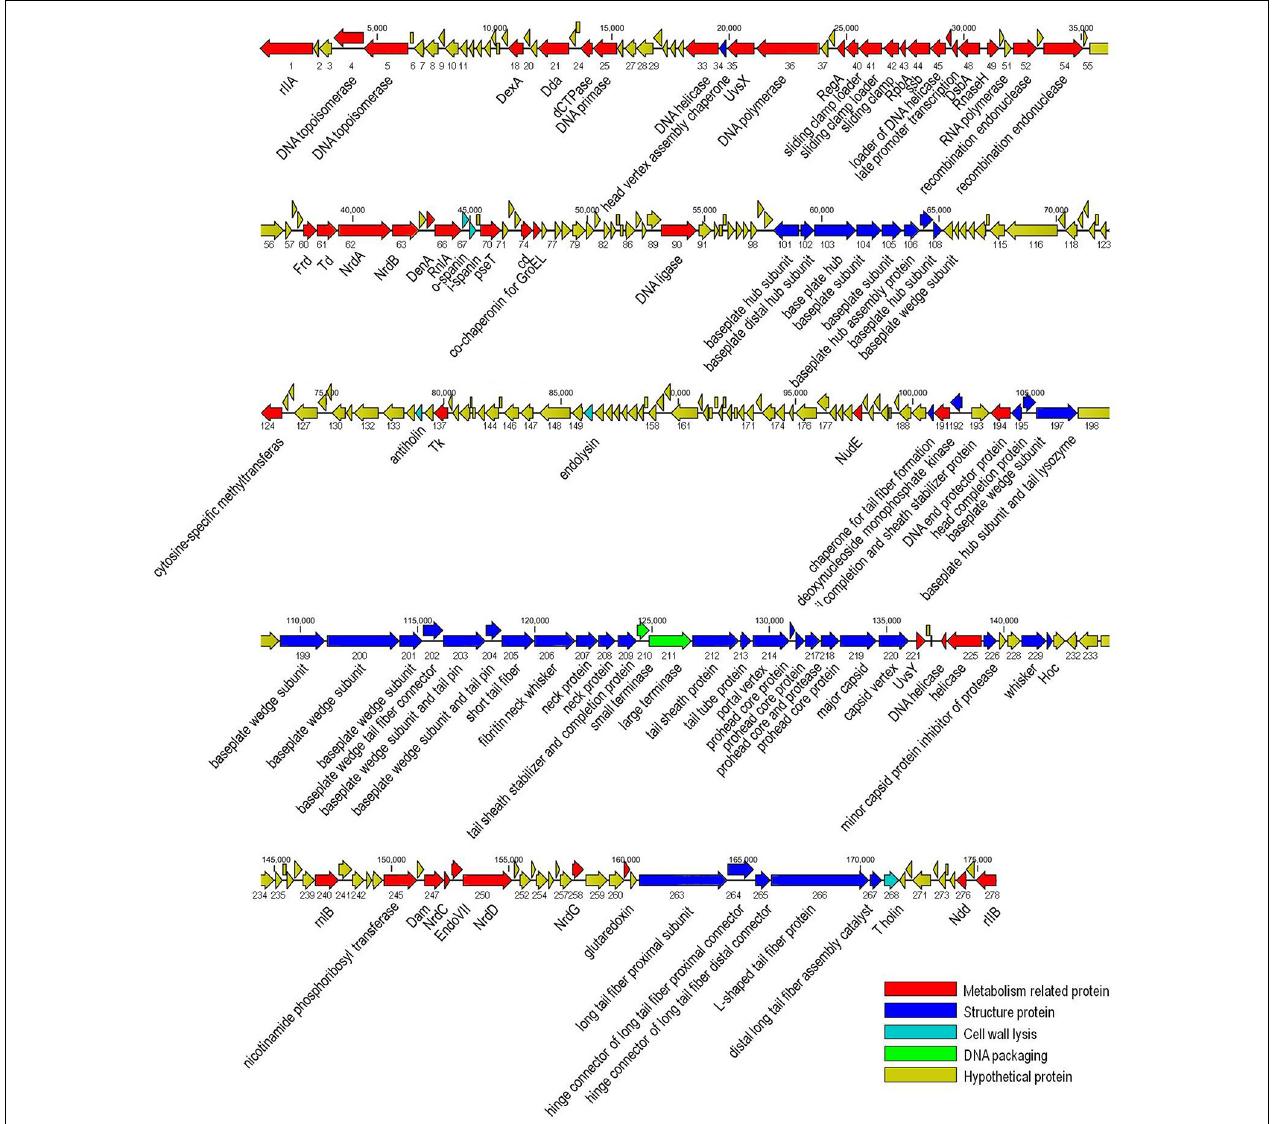
FIGURE 7 | Genome map of phage vB_EaeM_ ϕ Eap-3. The genome map was generated using the CLC Main Workbench, version 6.1.1 (CLC bio, Aarhus, Denmark). Predicted open reading frames are indicated by arrows, with the direction of the arrows representing the direction of